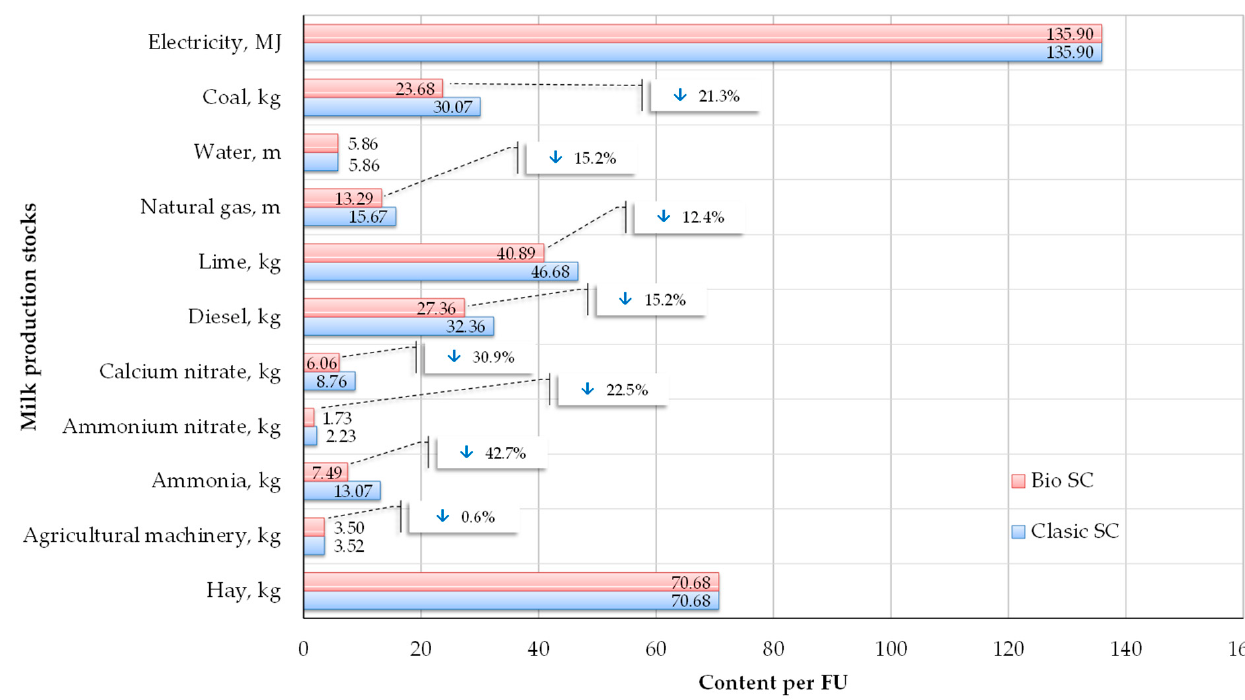
Figure 2. Results of the GHG potential (kg CO 2 eq. FU − 1 ) of the Classic SC processes. Critical points of the process are identified by a red bold line.